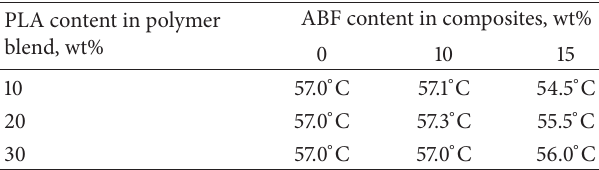
Table 3: 𝑇 𝑔 of PLA in polymer blends and composites. PLA content in polymer